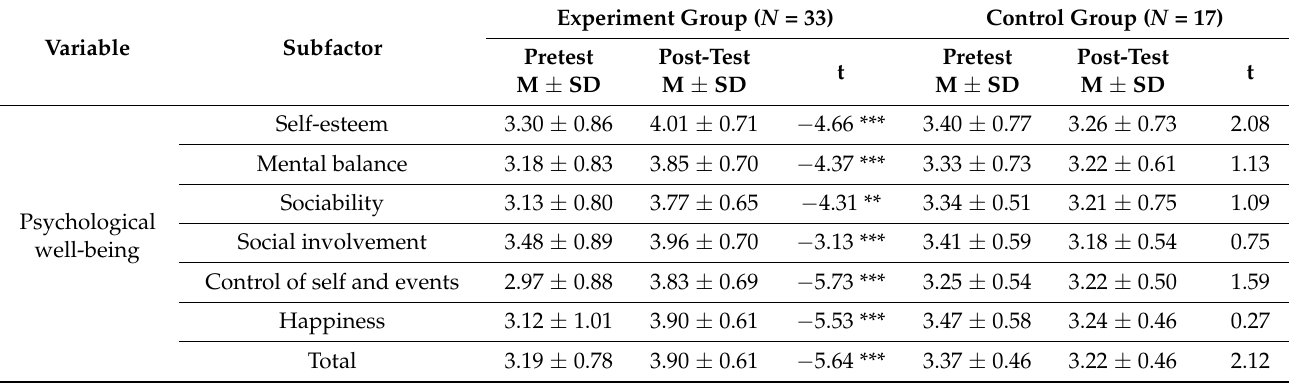
Table 3. Comparison of pre- and post-tests for psychological well-being between the experimental and control groups. Experiment Group ( N = 33) Control Group ( N = 17) Variable Subfactor Pretest Post-Test